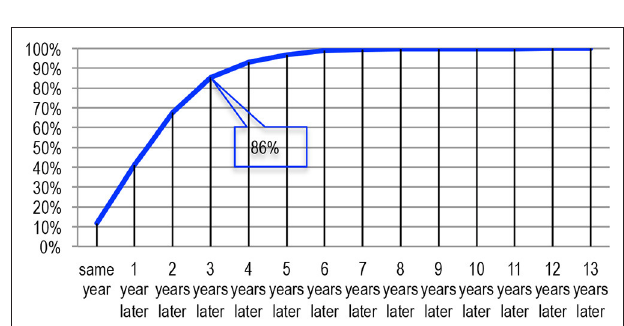
FIGURE 32 | Time delay between publication and reuse (in %).